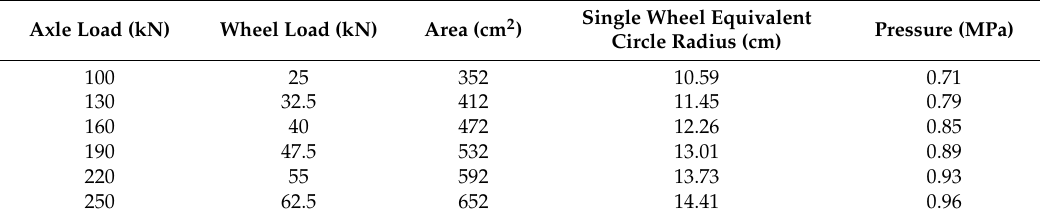
Table 3. Vehicle axle load calculations.